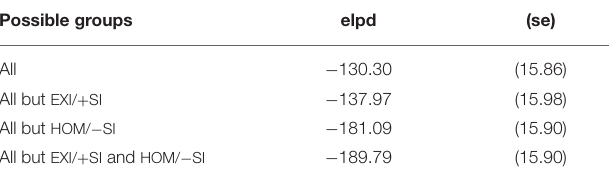
Possible groups